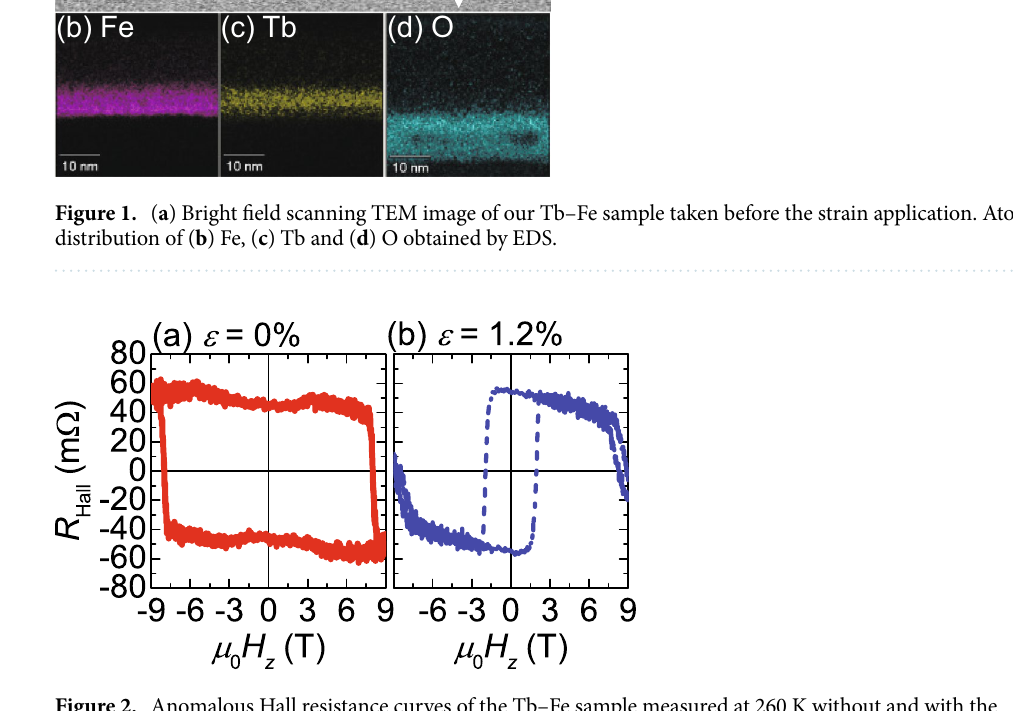
Figure 2. Anomalous Hall resistance curves of the Tb–Fe sample measured at 260 K without and with the strain ( ε = 0% and 1.2%,